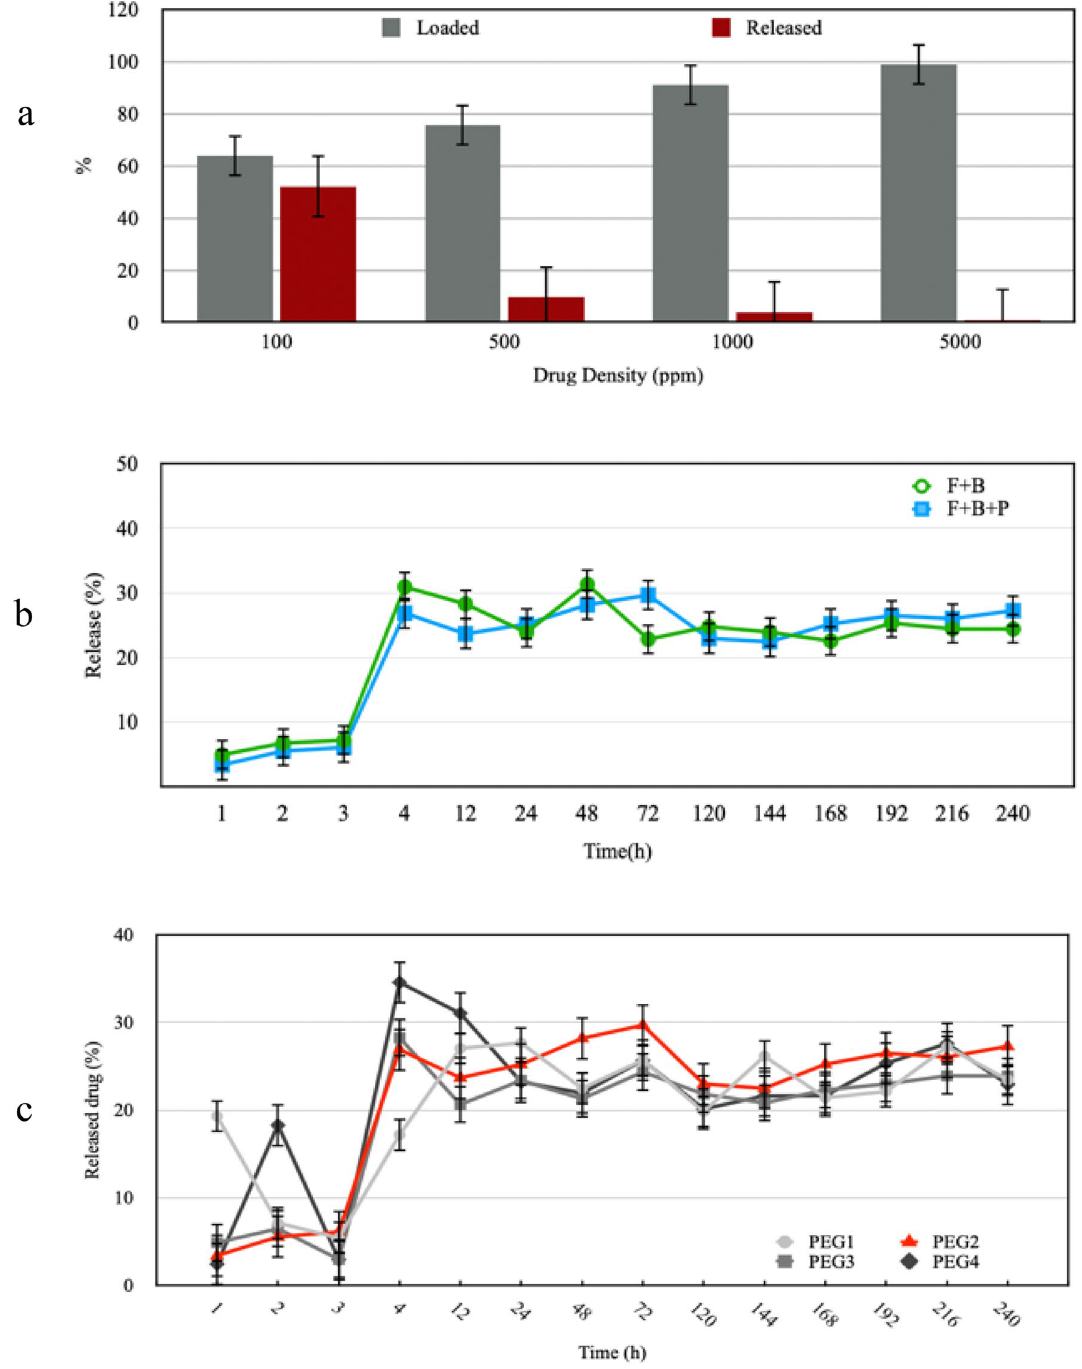
Figure 5. ( a ) Comparison of the effect of the density of the original solution of BET on the percentage of drug loading and releasing. ( b ) Comparison of the drug releasing percentage of the polymerized surface of F + B PP meshes. ( c ) Comparison of the drug releasing percentage of the surface of F + B and F + B + P PP